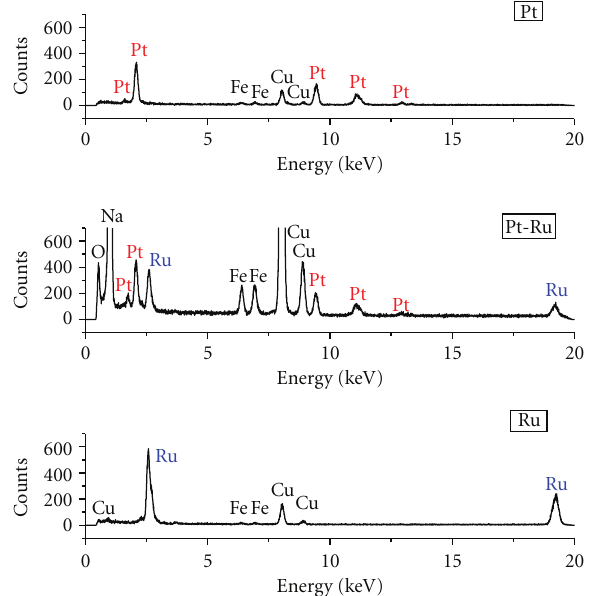
Figure 6: Amperometric curves and current-concentration rela- tionship (insert) of Pt (red), Pt-Ru (black), and Ru (blue) for H 2 O 2 injections at overpotential of